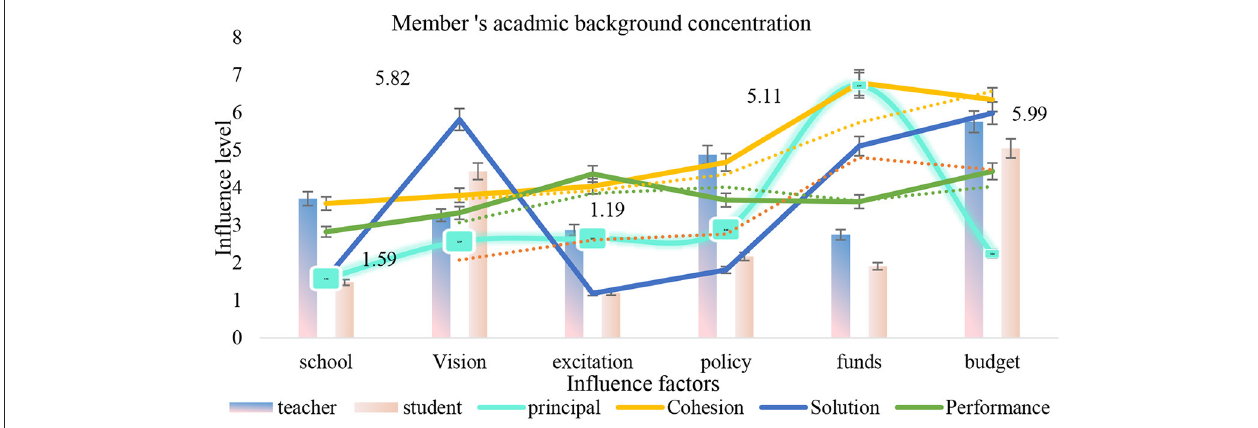
FIGURE 7 | Member’s academic background concentration.